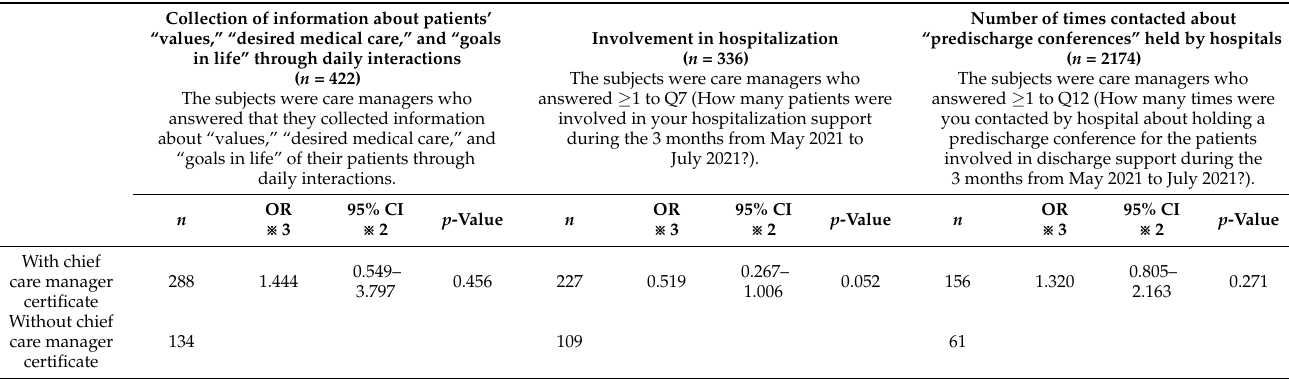
Table 6. Associations between the chief care manager certification status with the daily collection of information from patients, involvement in hospitalization and being contacted about “predischarge conferences” held by